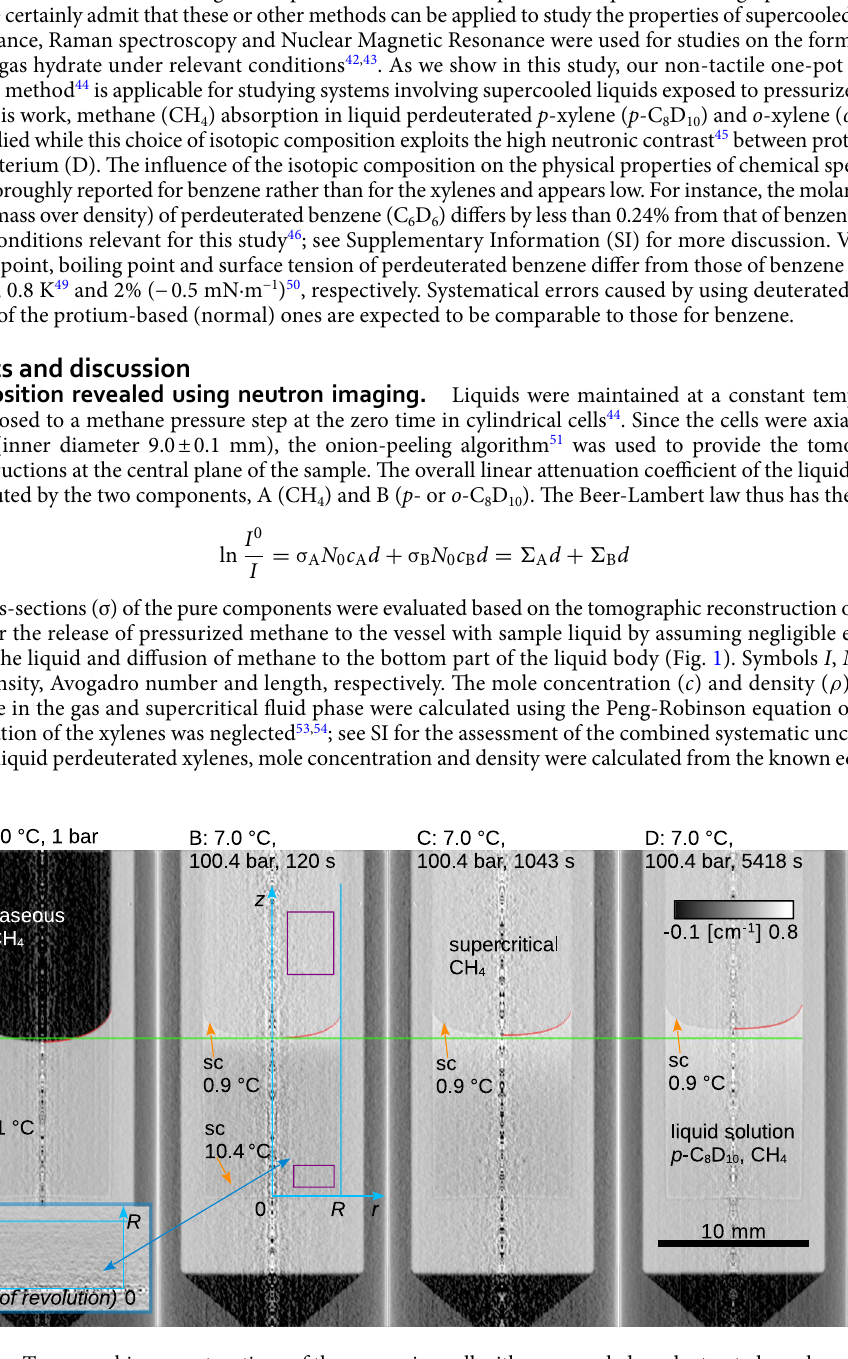
Figure 1. Tomographic reconstructions of the measuring cell with supercooled perdeuterated p -xylene ( p - C 8 D 10 ) exposed to methane at 1.0 bar ( A ) and at 100.4 ± 0.2 bar at 7.0 ± 0.2 °C ( A )–( D ). Time after exposure to pressurized methane, fits of the phase interface shapes (red curves), local level of supercooling (sc), axes and cell radial dimension (blue lines, 2· R = 9.0 ± 0.1 mm), and domains used for the calculation of the linear attenuation coefficient of the pure components (purple boxes) are indicated. Green dashed line is the liquid level at the cell center short after the pressurization. The bottom-left insert shows the body of revolution used for the calculation of the liquid